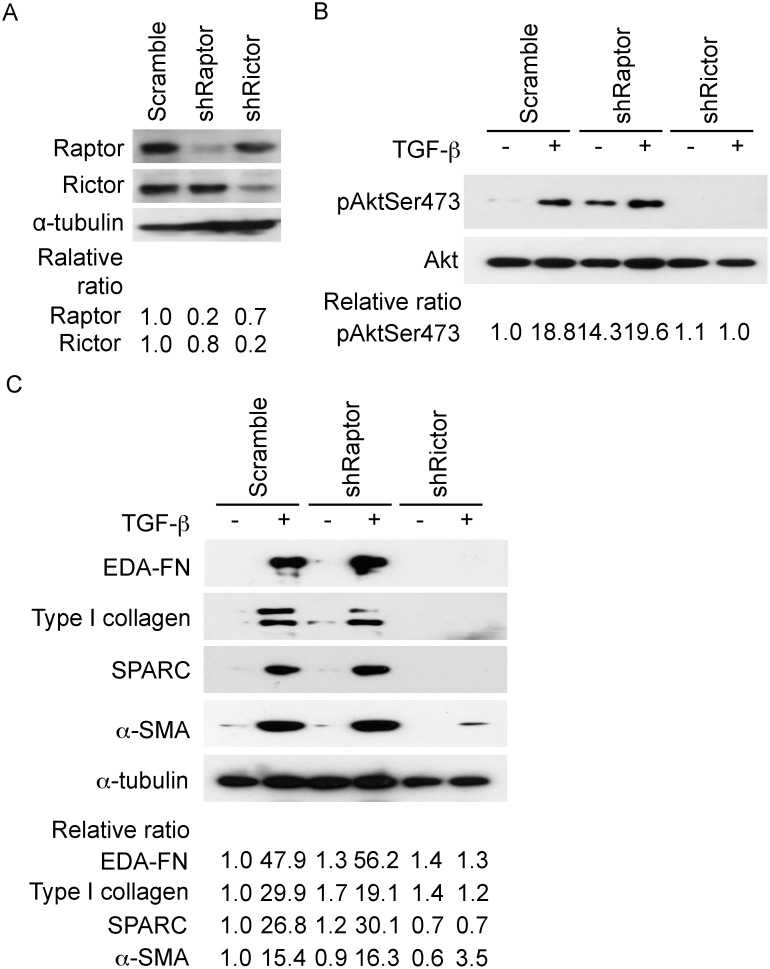
Rictor but not Raptor regulates Akt phosphorylation (Ser473) and the expression of matrix regulatory proteins.In (A) IPF fibroblasts isolated from surgical lung biopsy were infected with lentivirus-derived shRNA against raptor or rictor, or control (scramble) as described in Materials and Methods. Western blot analysis was performed with the indicated antibodies. α-tubulin was used as a loading control. (B) Serum-starved IPF fibroblasts were treated with TGF-β for 60 minutes followed by an analysis of Akt phosphorylation by Western blot analysis. Total Akt was used as a loading control. (C). Serum-deprived IPF fibroblasts were treated overnight with TGF-β followed by analysis of matrix-regulatory proteins by Western blot analysis. α-tubulin was used as a loading control. Experiments with the three IPF lines showed similar results and representative results from the surgical lung biopsy fibroblasts are shown.